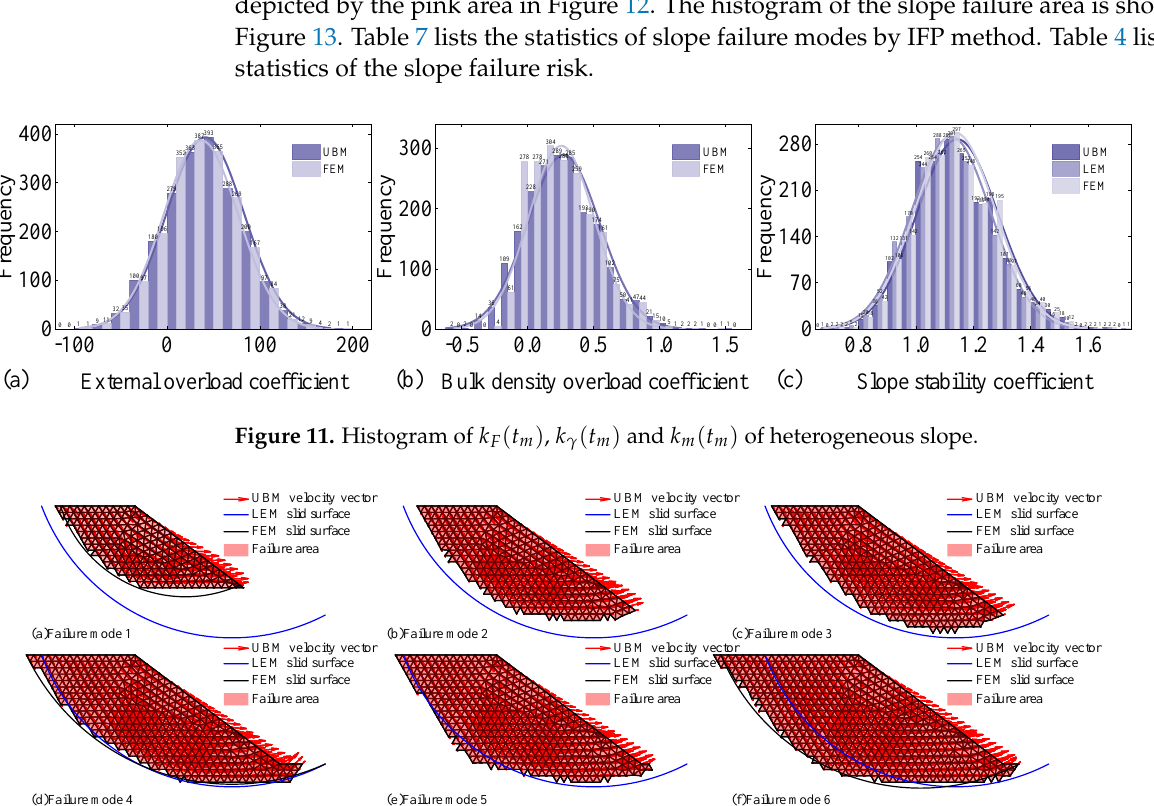
Figure 12. Heterogeneous Slope failure modes.